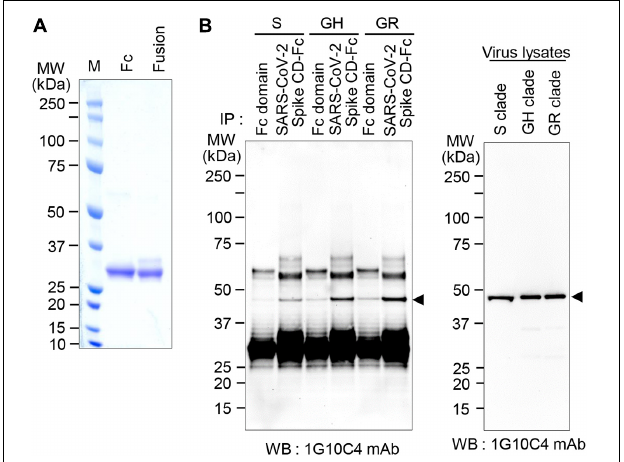
FIGURE 5 | N protein in SARS-CoV-2 S, GH, or GR clade virus particles interact with SARS-CoV-2 Spike CD. (A) Expression of SARS-CoV-2 Spike CD-Fc. The recombinant Fc control protein and the SARS-CoV-2 Spike CD-Fc fusion protein were expressed in ExpiCHO cells, purified from cell culture supernatants using Protein A column chromatography and analyzed by SDS-PAGE and Coomassie blue staining. (B) Interaction of the N protein in virus particles with SARS-CoV-2 Spike CD. Vero cells were infected with SARS-CoV-2 S, GH, or GR clade at a MOI of 0.01 for 72 h and then cell culture supernatants were collected. Cell culture supernatants were lysed with cell lysis buffer and incubated with Fc or SARS-CoV-2 Spike CD-Fc. Fc-bound proteins were pulled down with Protein A beads and subjected to western blot analysis using the anti-SARS-CoV-2 N protein-specific monoclonal antibody (clone 1G10C4 mAb). Western blot of virus lysates is shown as a